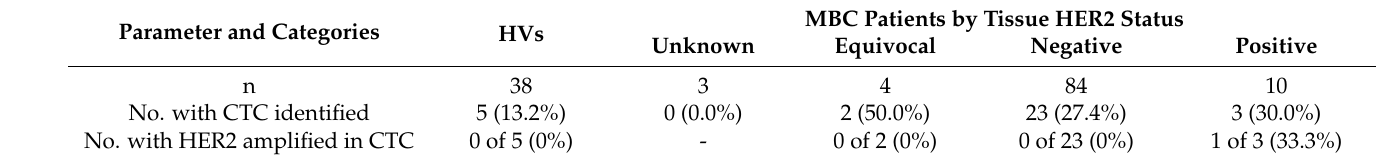
Table 5. Results from evaluation of Parsortix harvests using HER2 FISH. The number and proportion of samples with CTCs identified on the FISH slide and the number and proportion of samples showing CTCs with HER2 amplification in the HV subjects and MBC patients by their tissue HER2 status. MBC Patients by Tissue HER2 Status Parameter and Categories HVs Unknown